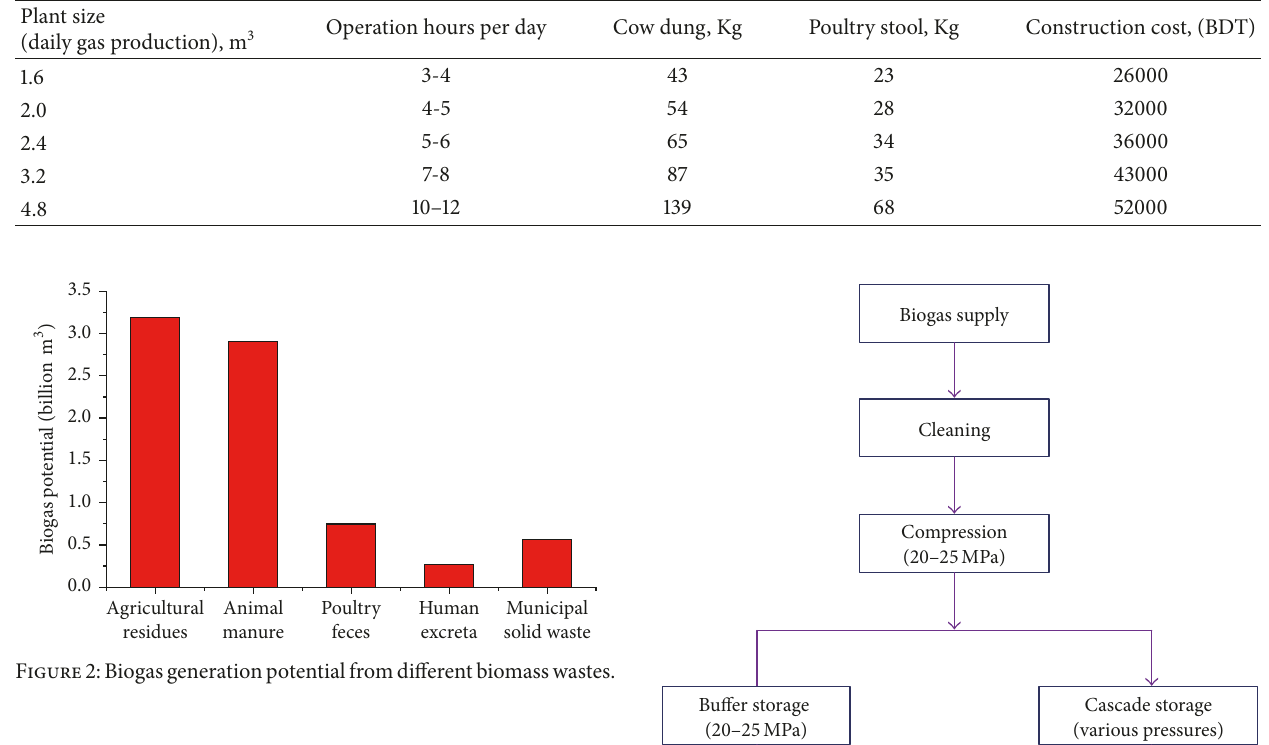
Table 3: Plant based daily biogas production data in Bangladesh [47].